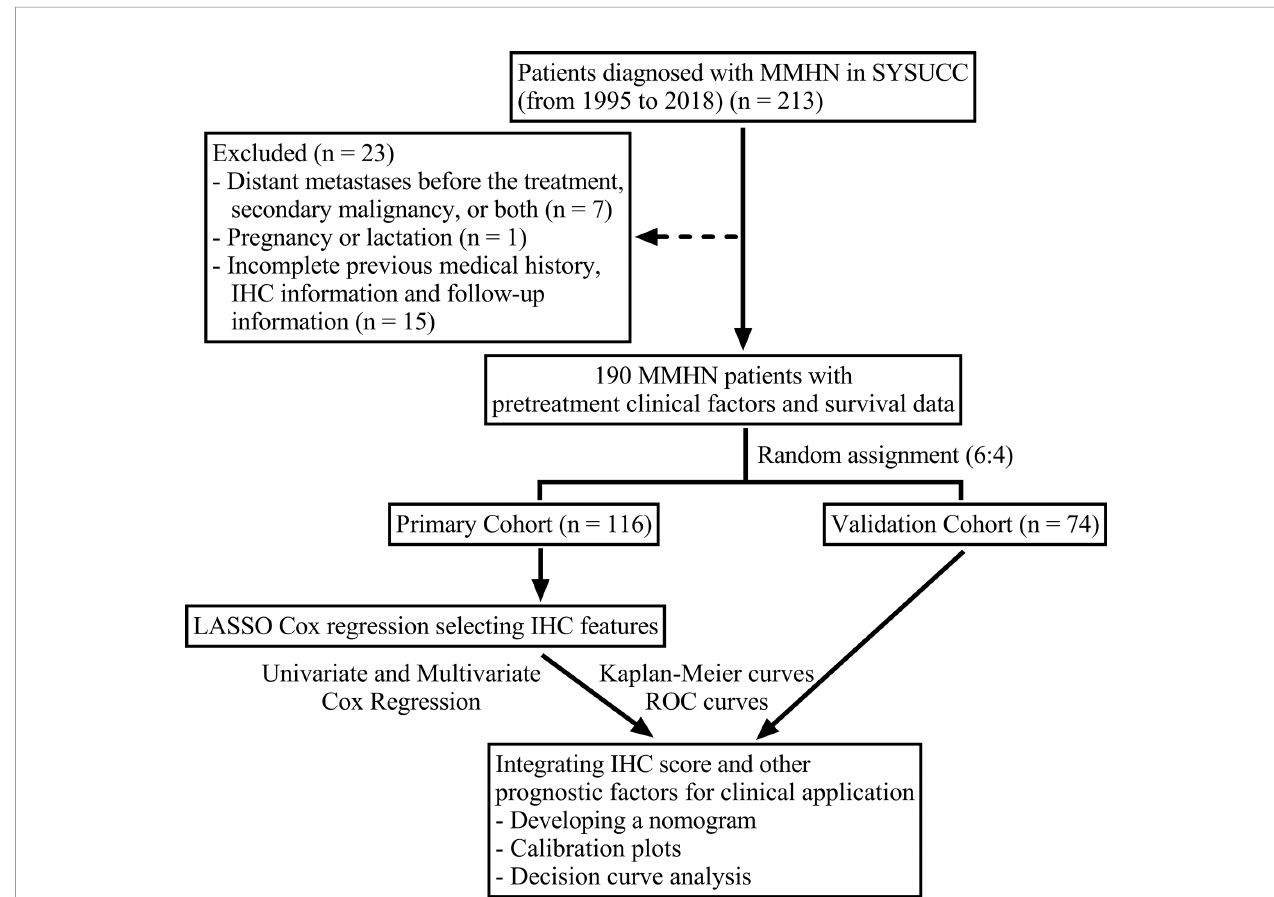
FIGURE 1 | Flow chart of the study design. MMHN, mucosal melanoma of the head and neck; SYSUCC, Sun Yat-Sen University Cancer Center; IHC, immunohistochemistry; ROC, receiver operating